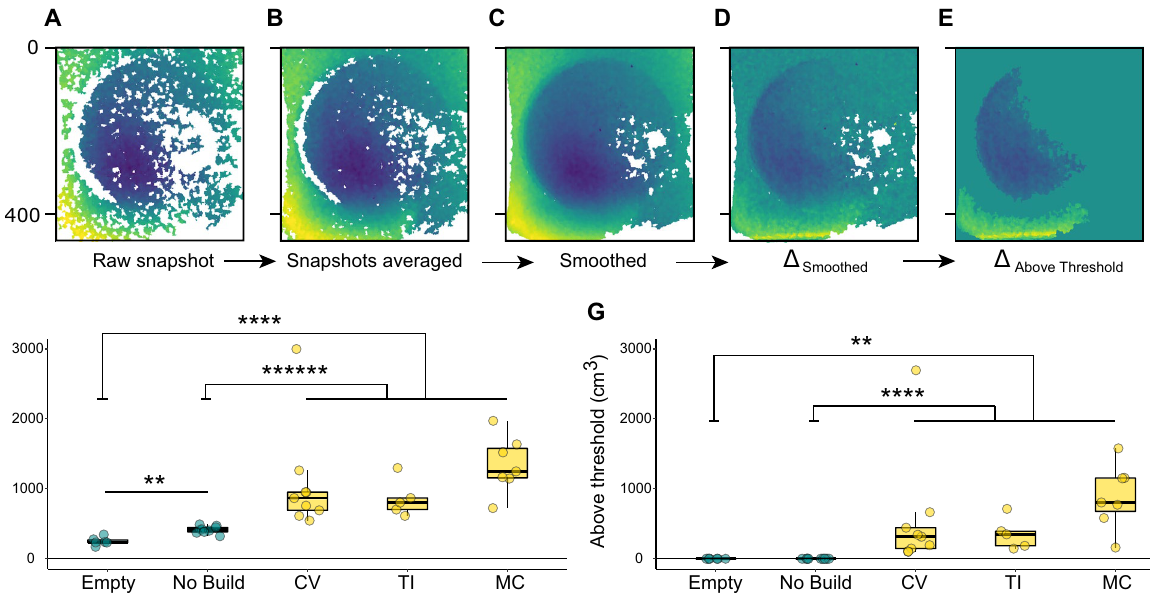
Figure 2. Depth sensing detects structural change associated with bower construction. The Kinect collects top-down depth snapshots of the sand tray surface through time ( A – E ), with yellow indicating distances closer to Kinect (elevated regions), and dark blue indicating regions farther from the Kinect (depressed regions). Raw Kinect depth snapshots of the sand tray surface contained ~ 40% missing data (white pixels; ( A )). To improve depth data quality, consecutive depth snapshots were collected and averaged together every 5 min, reducing the proportion of missing data to ~ 20% ( B ). Data quality was further improved by spatially interpolating data in small NaN “islands,” reducing the proportion of NaN pixels to ~ 10% ( C ). Depth change over the course of the trial was calculated by subtracting the initial depth map from the final depth map, with turquoise indicating no change ( D ). Thresholding enabled depth change signals caused by bower construction to be separated from signals caused by noise and other home tank activities ( E ). Before thresholding, total volume change differed strongly between control trials (Empty tank trials, and trials in which no bower was constructed) and bower construction trials ( F ). Following thresholding, all bower trials exhibited above threshold volume change while control trials did not ( G